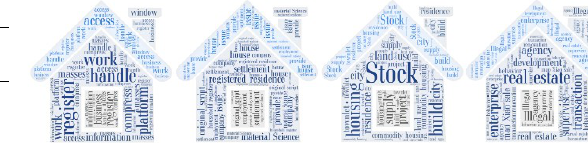
Figure 5. Cloud map visualization of policy keywords in June 2017, the pictures indicate Convenience of Real property registration, Settlement policy, Real estate inventory and Regulate Real Estate Development and